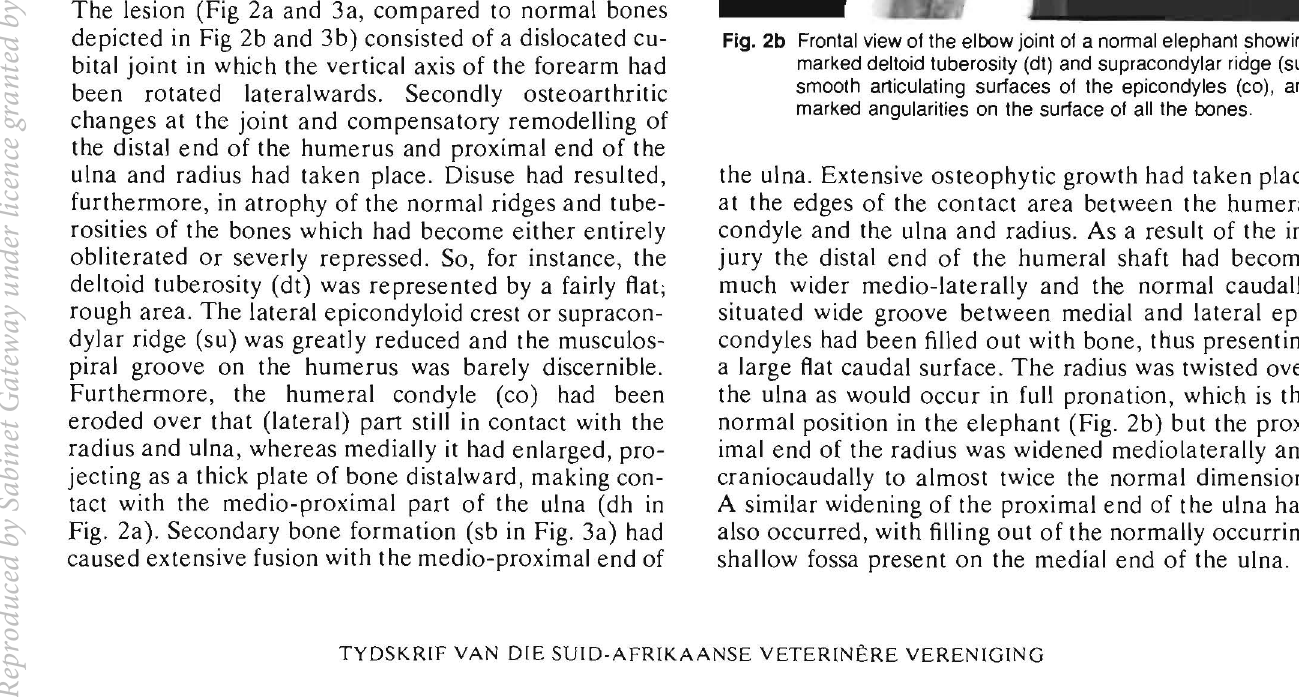
Fig. 2a Frontal view of the humerus (hu), radius (ra) and ulna (ul) of the injured elephant showing remodelling of the bones with the supracondylar ridge (su) of the humerus reduced, the distal end of the humerus (dh) growing around the head of the ulna and the replacement of the epicondyles (co) by sec· ondary bone growth.